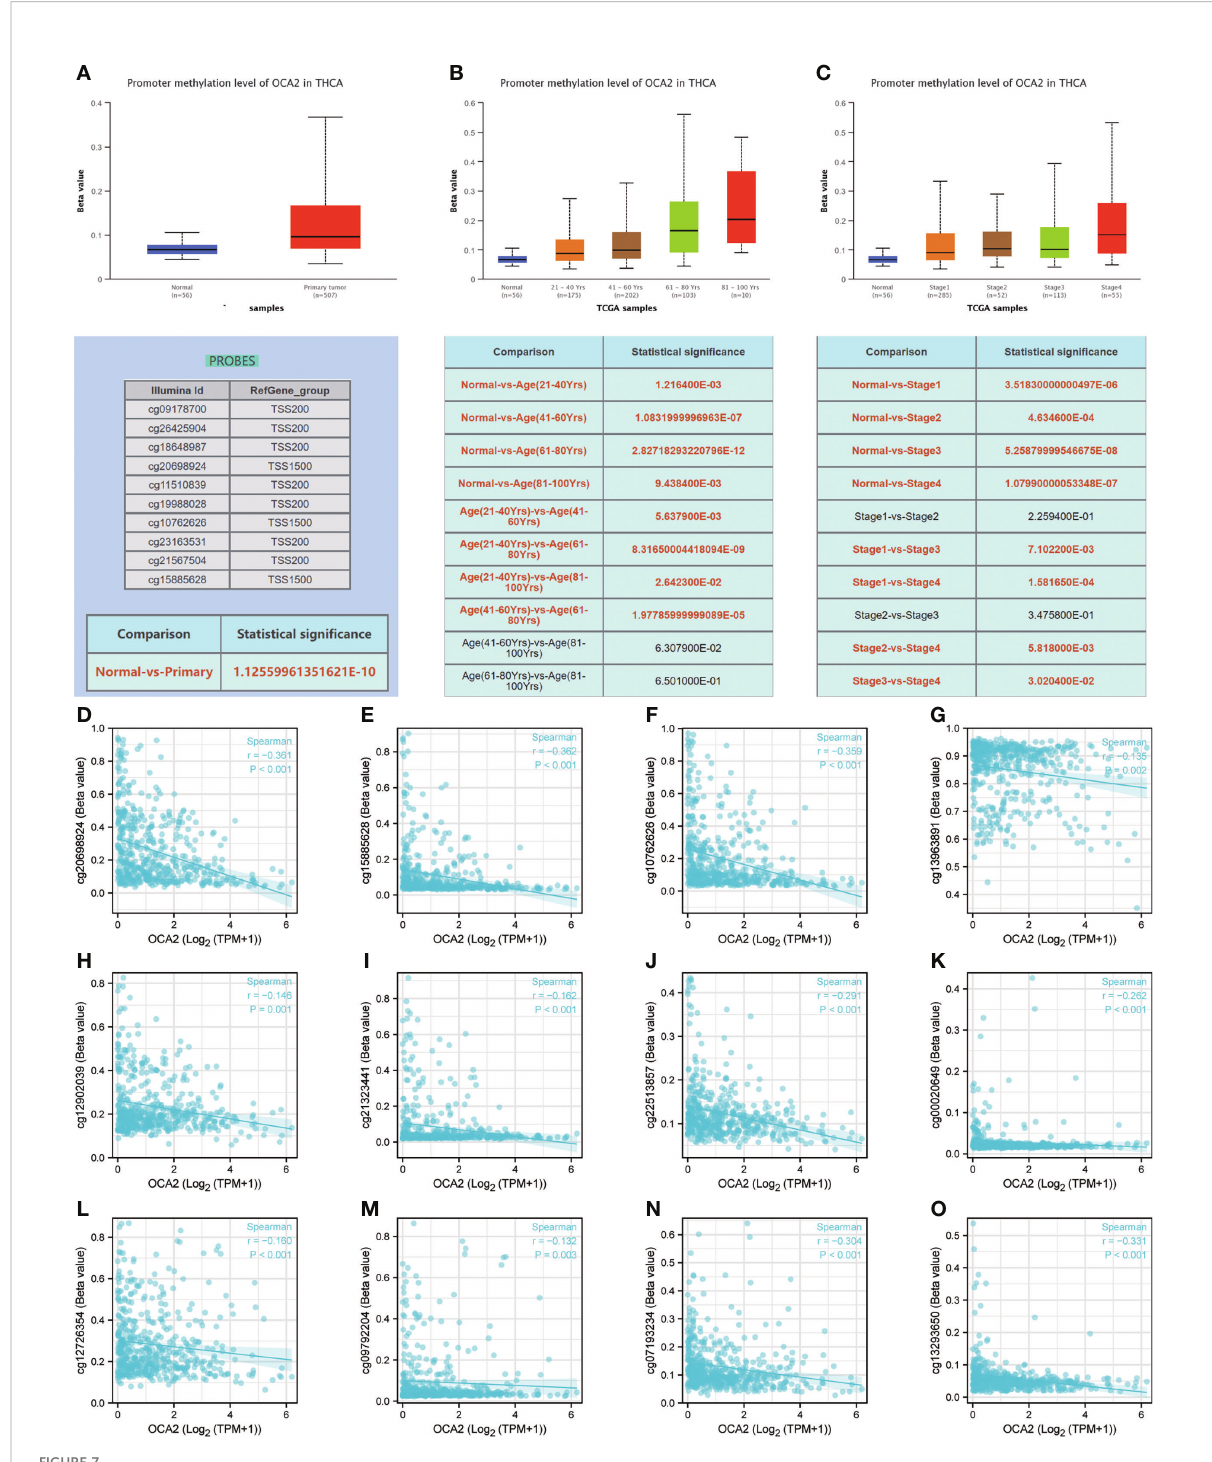
FIGURE 7 DNA methylation of OCA2. Expression of OCA2 DNA methylation level in THCA and normal tissues (A) . Expression of OCA2 DNA methylation levels in THCA patients of different ages (B) . Expression of OCA2 DNA methylation levels THCA patients with different pathologic stages (C) . Different CpG sites of OCA2 methylation levels in THCA (D – O)